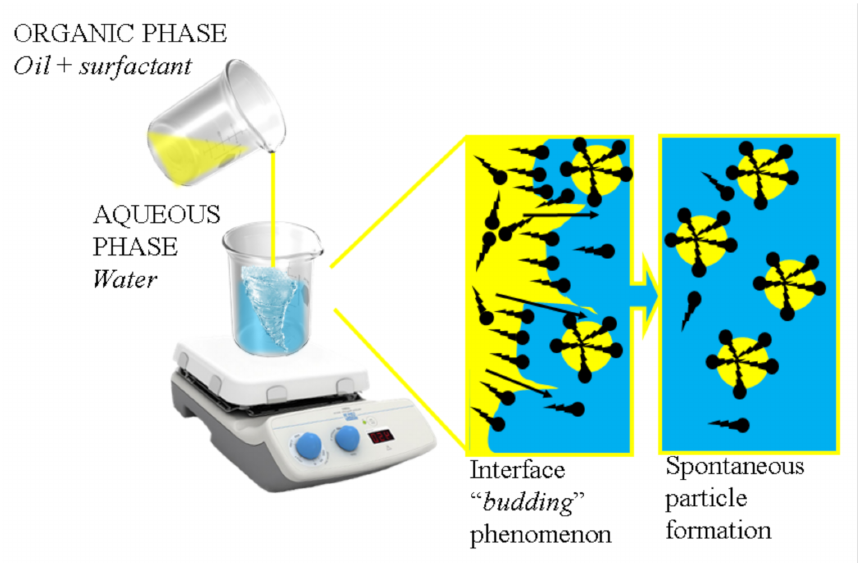
Figure 4. Illustration of the spontaneous emulsification mechanism. This is a self-drawn